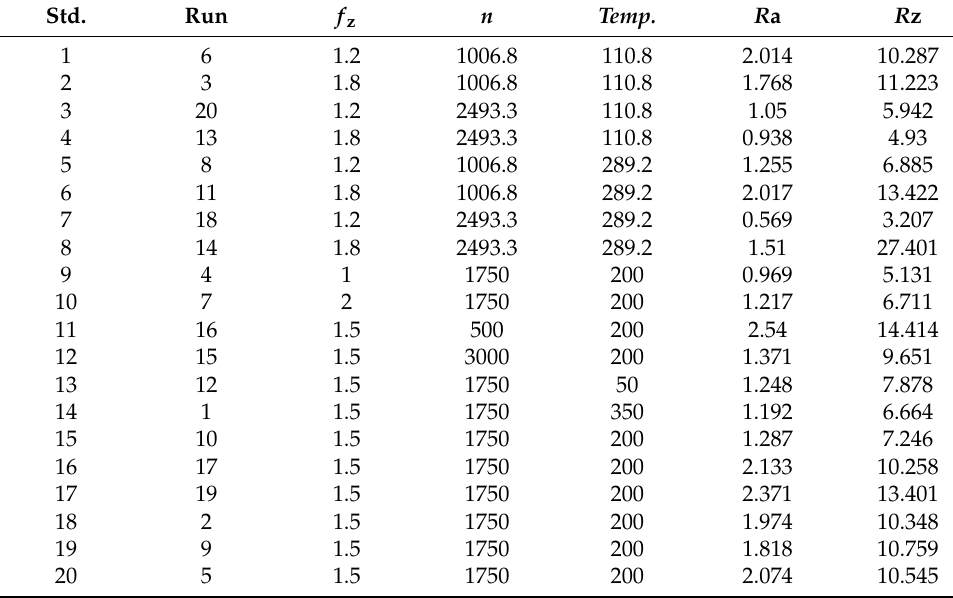
Table 3. Table of CCD with observed and predicted responses.